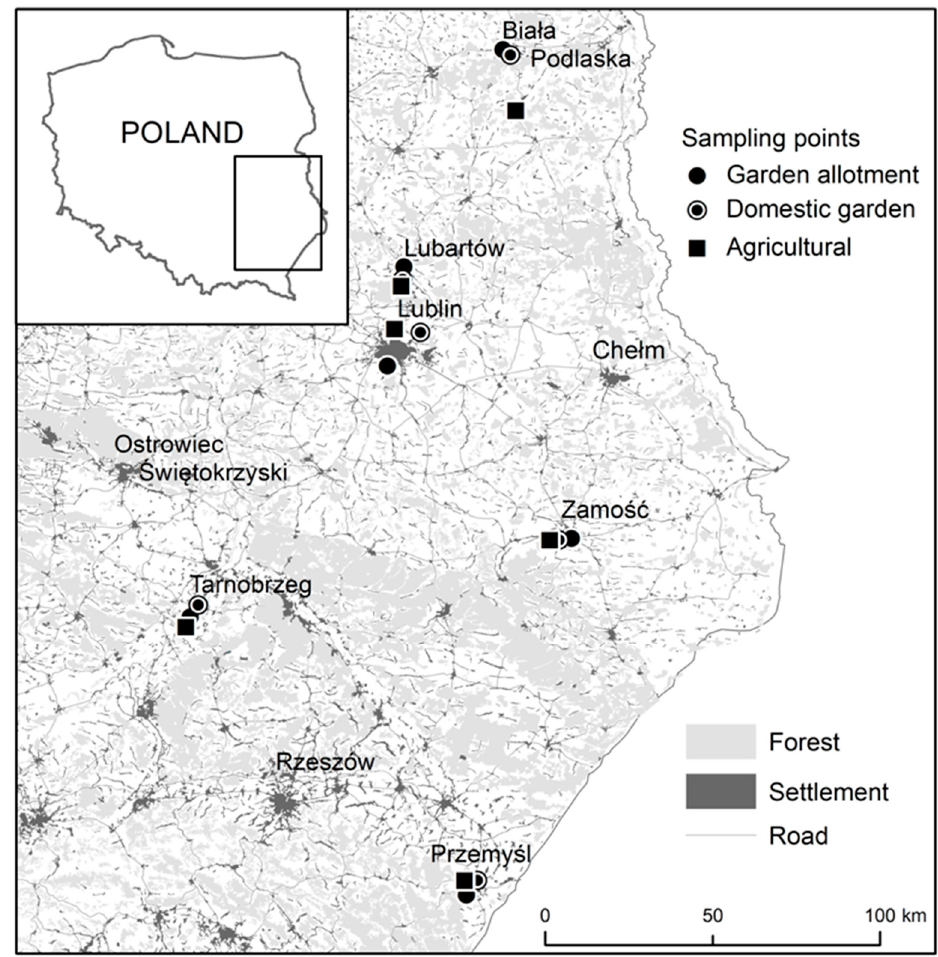
Figure 1. Map of sampling in the study area.